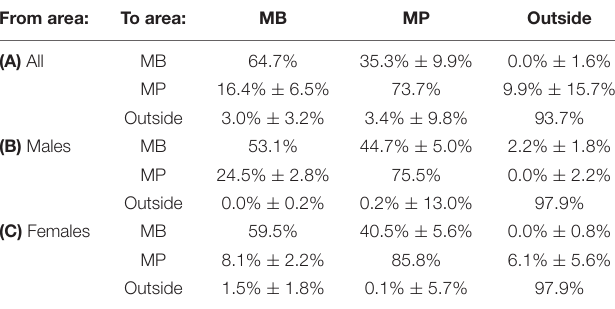
table) were used to compare sex ratio data for each site, while a two-dimensional contingency table was used to compare sex ratios and behavior frequencies between the two